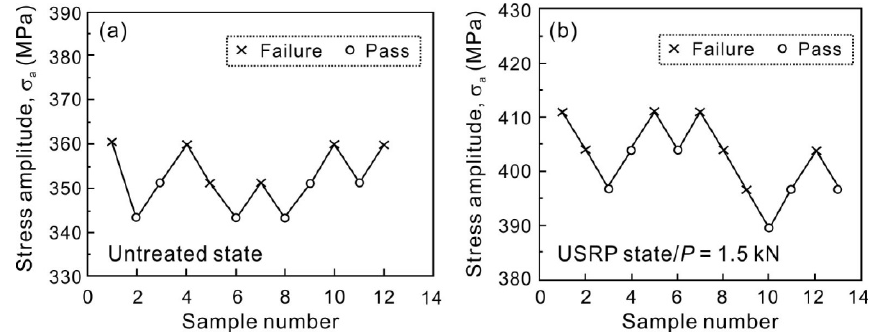
Figure 6. Staircase diagram of the specimens in ( a ) the untreated state and ( b ) the USRP state with a static load P of 1.5